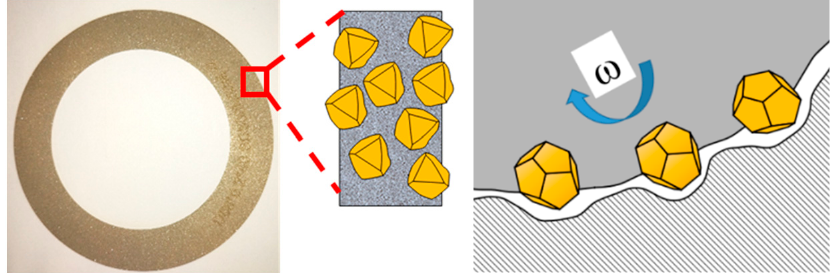
Figure 1. Schematic diagram of dicing process.